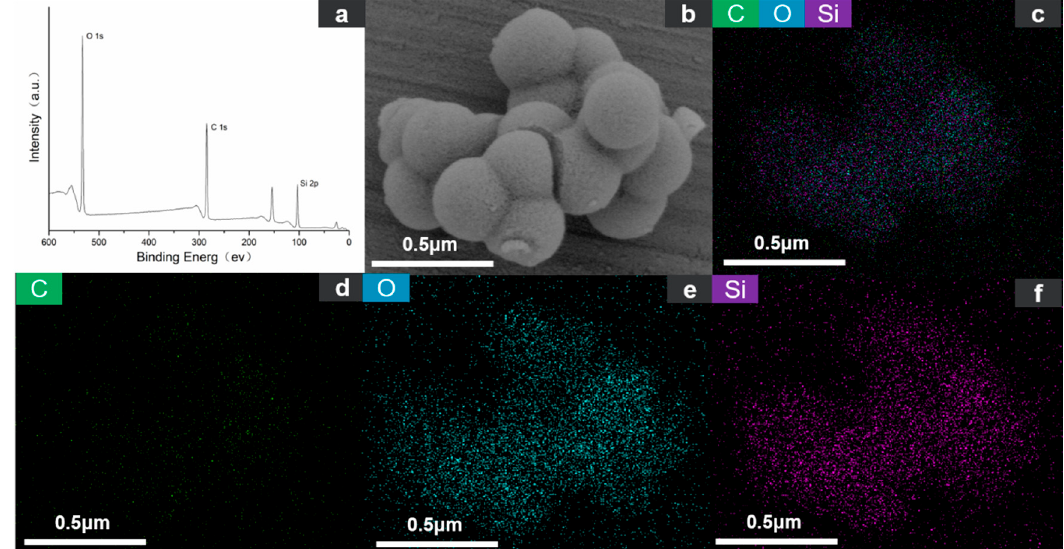
Figure 5. ( a ) XPS, and ( b – f ) EDX element distribution images of organic hollow mesoporous silica with the highest oil-loading and dispersion in water. Green, blue and purple denoted C, O and Si, respectively. The scales in ( b – f ) was 0.5 µ m.